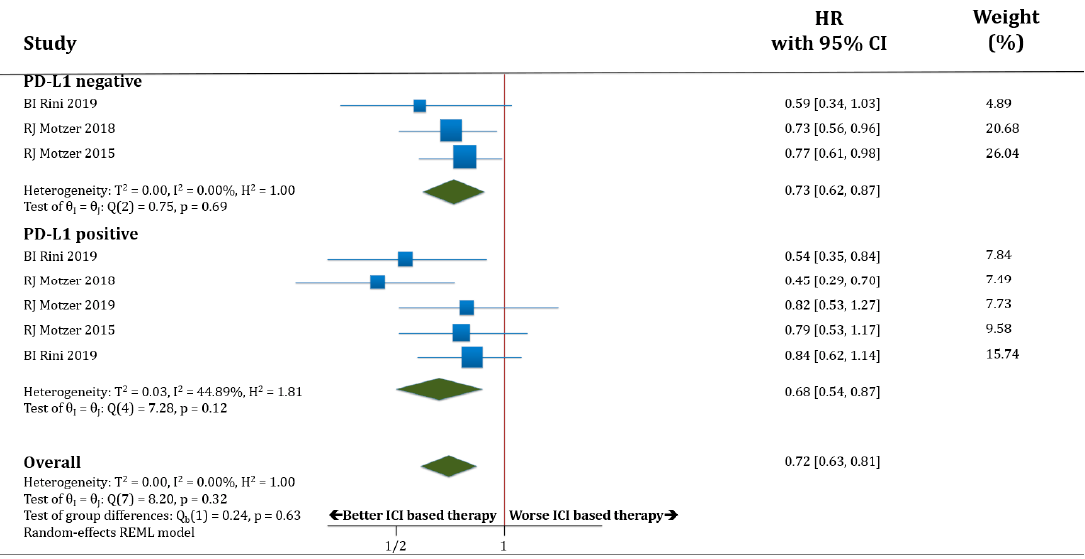
Figure 3. Forest plot diagram: hazard ratio (HR) with 95% confidence interval of overall survival (OS) between arms according to PD-L1 expression subgroups.